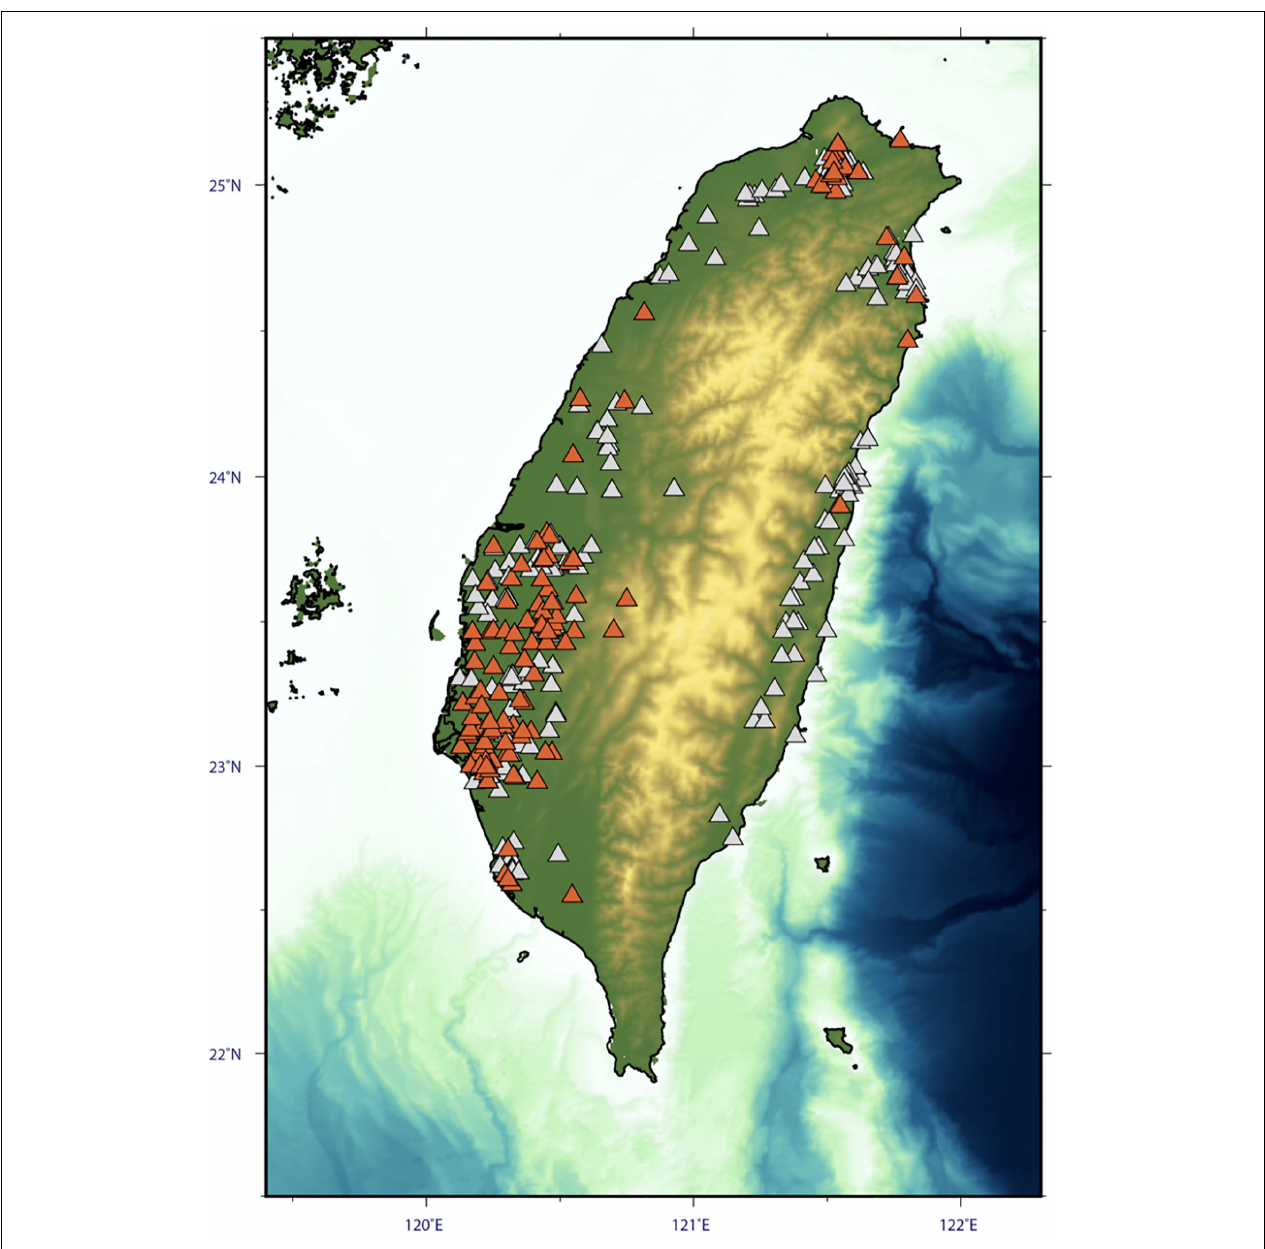
FIGURE 1 | The distribution of QCN in Taiwan. The active stations are indicated by orange, while the inactive stations are shown by